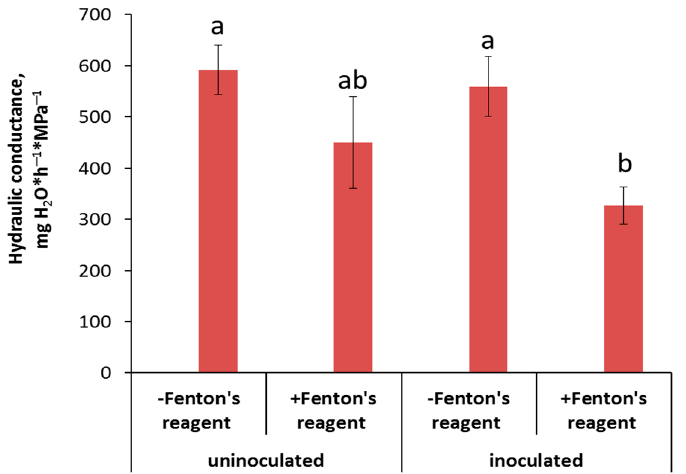
Figure 6. The effect of AQP inhibition on hydraulic conductance of control and inoculated with Pseudomonas mandelii IB-Ki14 pea plants (n = 6). Significantly different group-level means within each treatment are labeled with different letters (Duncan’s test, p ≤ 0.05).